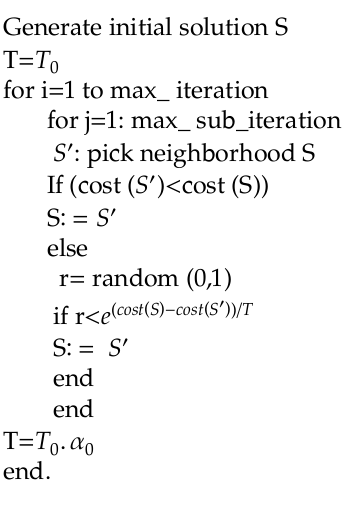
Algorithm 1. The proposed SA